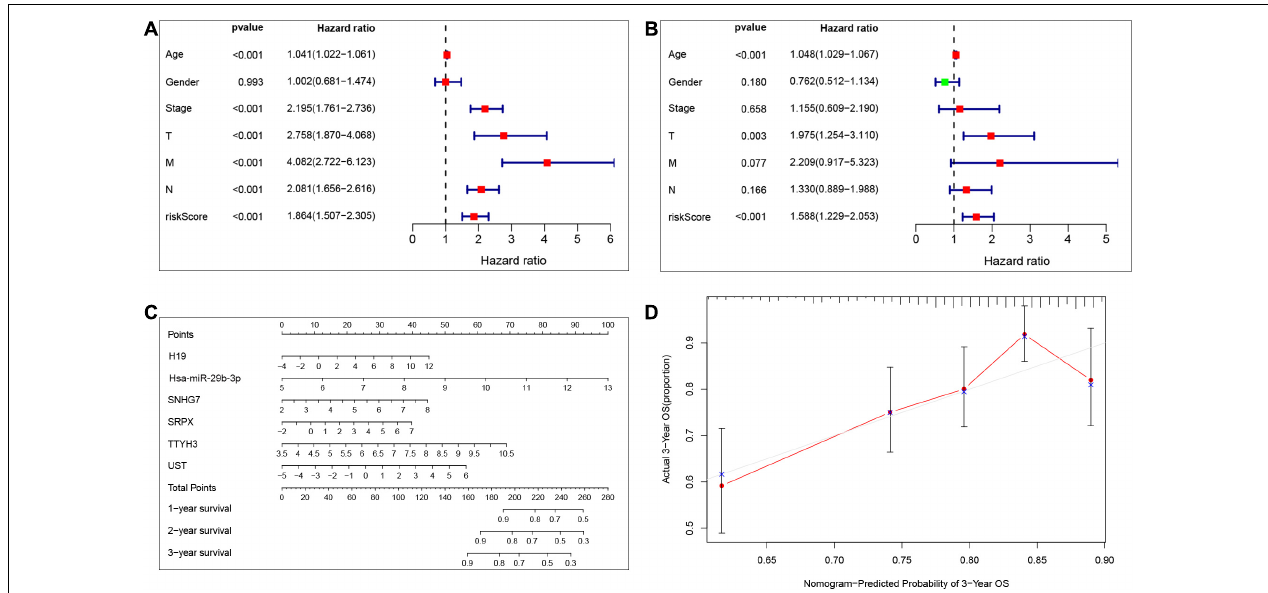
FIGURE 6 | Independent prognostic value of the risk model. Univariate Cox regression analysis and multivariate Cox analysis was performed to verify the independent prognostic value of the risk model (A,B) . Nomogram graph was plotted to predict patients’ survival time (C) . Calibration curve of the nomogram (the horizontal and vertical axes represent the predicted survival probability and the actual survival probability, respectively; red segments separately represent the 3-years survival rate in the group with the highest consistency) (D) .